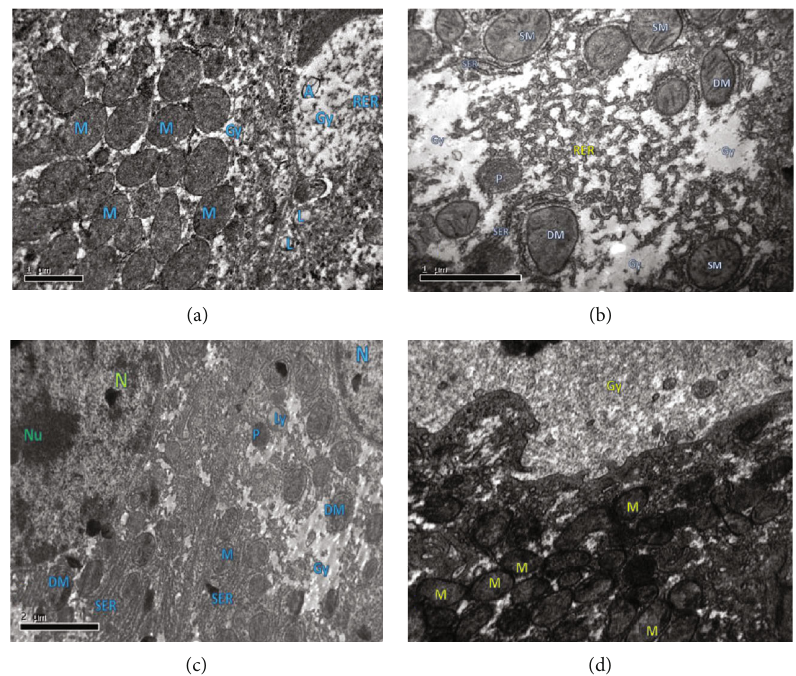
Figure 14: Transmission electron micrographs represent the ultrastructural features of liver tissues of rats from each experimental group. (a) Control group showed numerous mitochondria (M) — mitochondria were spherical and round-shaped, depending on the location within the cell; clumps of glycogen surrounded (Gy), adipocytes (A), lysosome (L), and dense granulated cytoplasm were seen in the control group. (b, c) DEN-treated group tissues showing few mitochondria (M), and some of them are losing their shape (DM) and swollen mitochondria (SM), presence of glycogen clump (Gy), and broken SER. (c) Nucleus (N) with initial stage of chromatin disintegration (Nc) and few mitochondria (M), and some of them are losing their shape (DM), presence of glycogen clump (Gy), well-developed SER-ER tubule, few lysosomes (Ly), and presence of few peroxisomes (P). (d) DEN plus 6-gingerol-treated group tissues showed the presence of numerous small mitochondria (M); most of the mitochondria are spherical or round normal shaped, with dense granulated cytoplasm (C), presence of glycogen clump (Gy), and presence of lysosome (Ly).